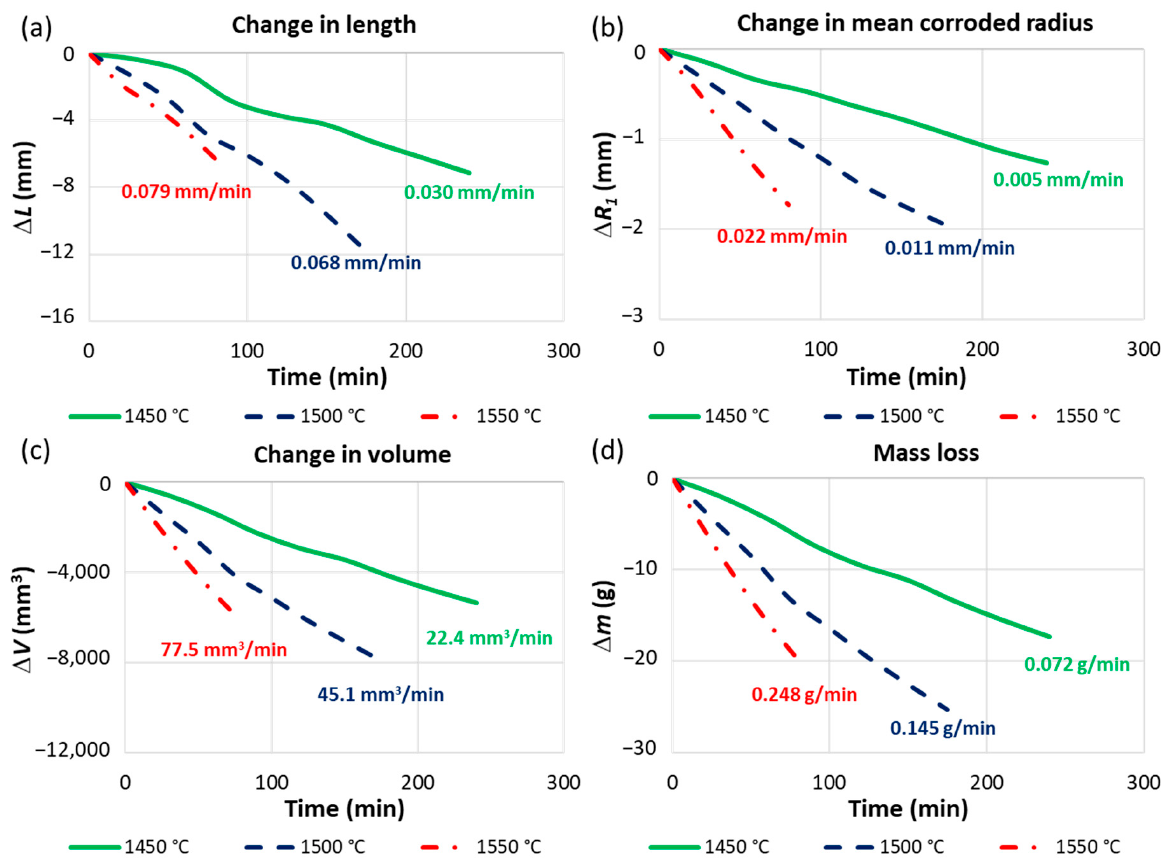
Figure 4. Change in ( a ) length, ( b ) the mean corroded radius, ( c ) volume, and ( d ) mass for the magnesia dissolution at 200 rpm and 1450, 1500, and 1550 °C. The numbers within the graphs indicate the average rate over the total dissolution time.